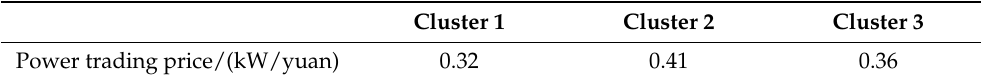
Figure 6. Total cluster output on target load curve fitting effect. Figure 7. External power interaction curve of the system.